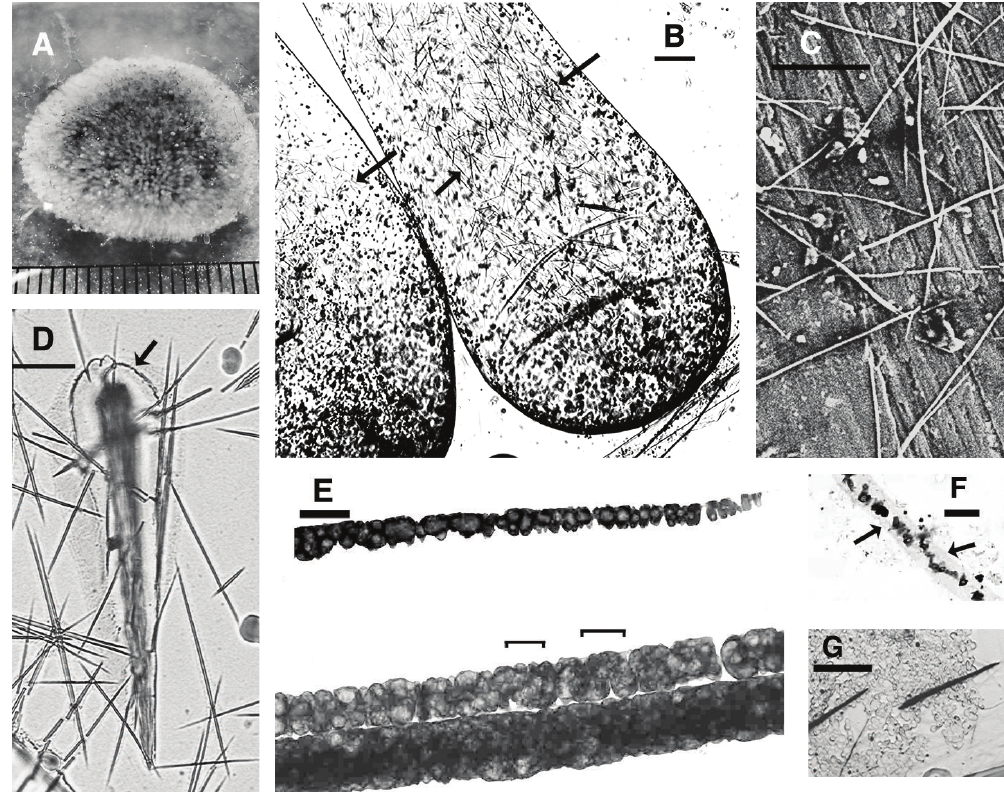
Figure 1: Calcium oxalate needles and bundles of needles in Codium minus : (A) C. minus ; (B) utricle with needle bundles and individual needles (arrows). (C) SEM of individual needles. (D) Individual needles and a needle bundle, the latter contained within a matrix or membrane (arrow); (E) and (F) TEM of needle tips showing twisting of crystal (E, brackets) and an apparent membrane about individual needles (arrows); (G). Needle bundle staining intensely for calcium oxalate (Yasue [22]). Scale bars: (A) ruler in mm; (B) 100 µ m; (C) and (D) 20 µ m; (E) and (F) 0.5 µ m; (G) 50 µ